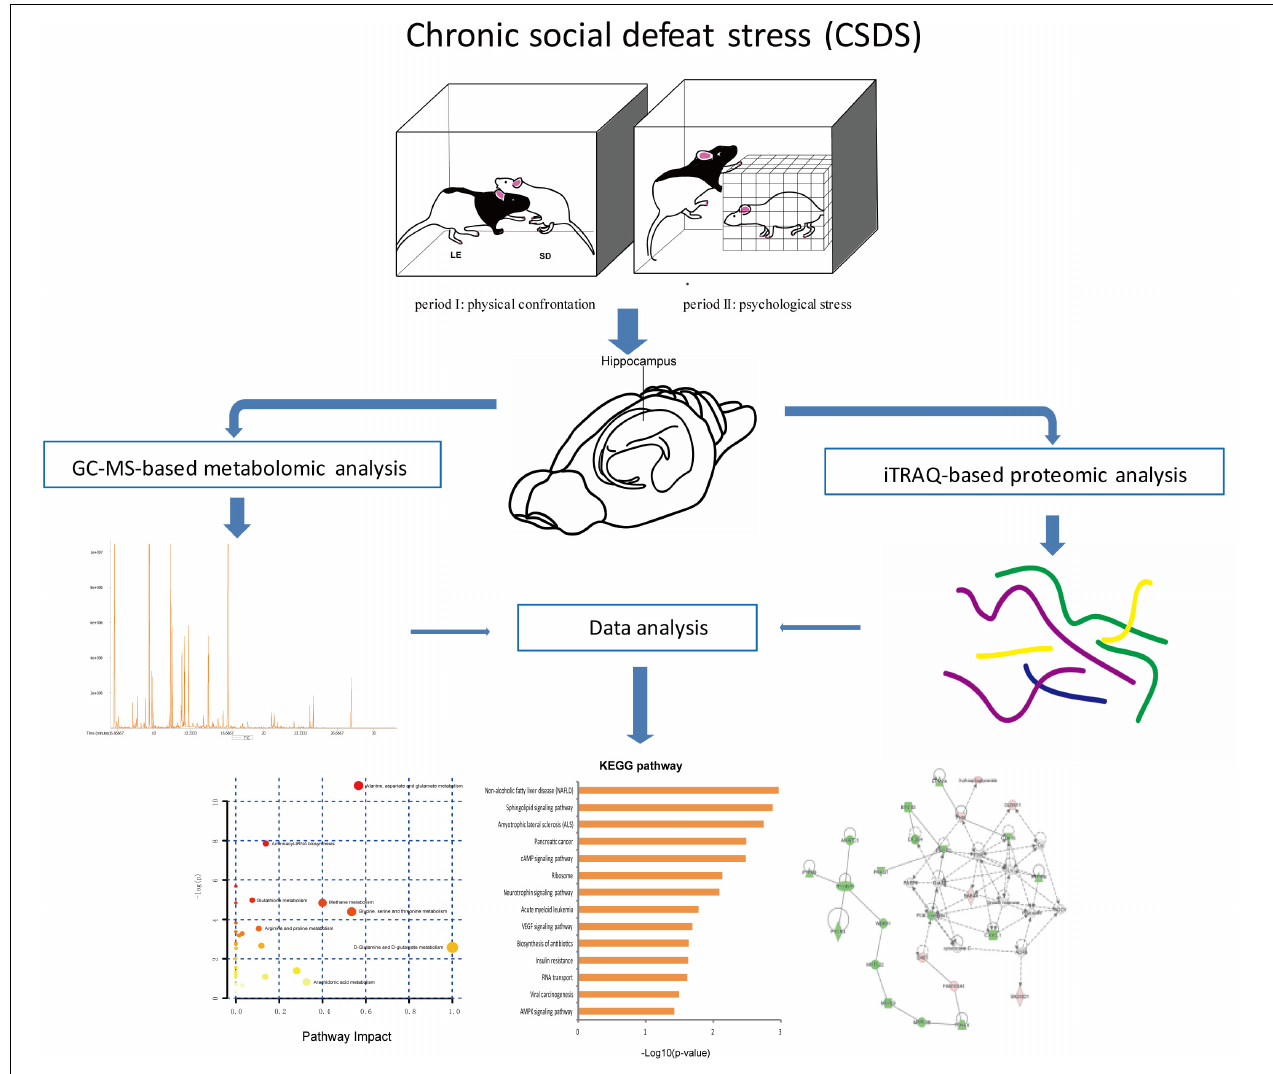
FIGURE 1 | Experimental flowchart.